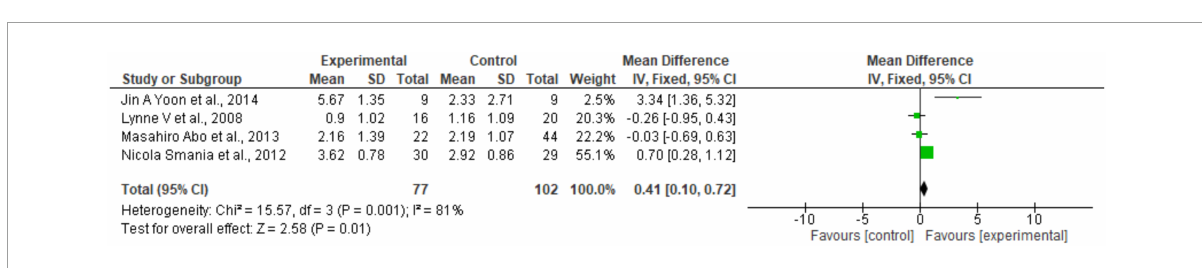
FIGURE3 Forest Plot of the manual function assessed by the Wolf Motor Function test. SD, standard deviation; CI, confidence interval.